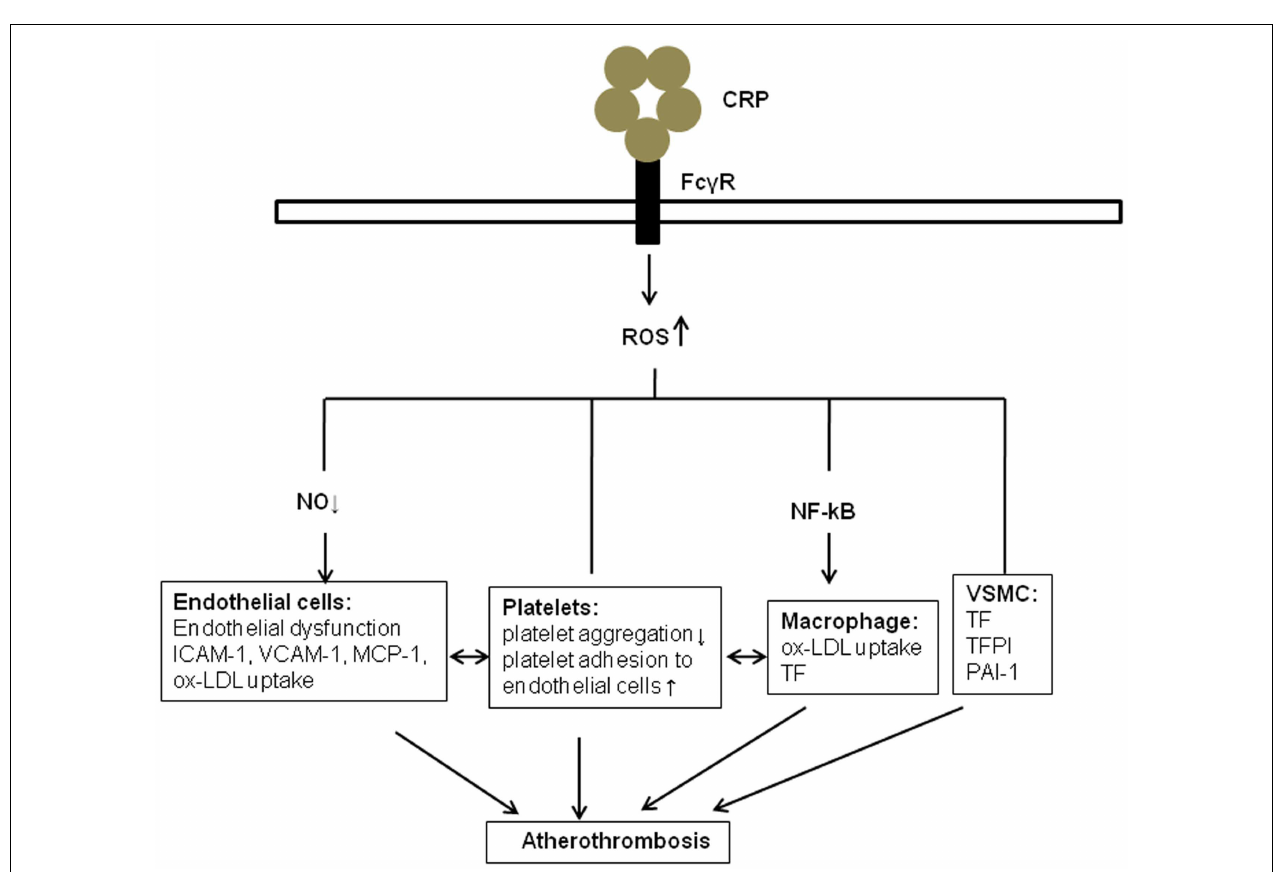
These molecules and cell–cell interactions, in turns, may contribute to endothelial dysfunction, release of cytokines. Ox-LDL, Oxidized low-density lipoprotein;VSMC,Vascular smooth muscle cell; MCP-1, monocyte chemoattractant protein-1; ICAM-1, intercellular adhesion molecule-1; VCAM-1, vascular adhesion molecule-1;TF, tissue factor;TFPI, tissue factor pathway inhibitor; PAI-1, plasminogen activator